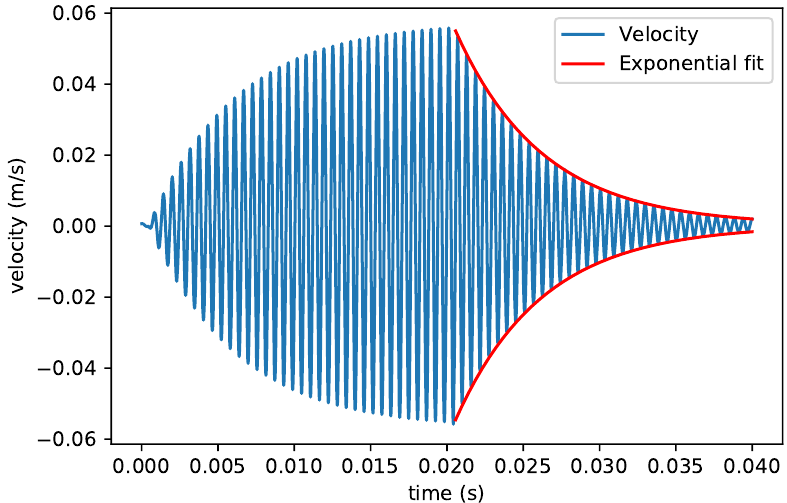
Figure 9. Measured velocity of the vibrating channel and exponential fit of the ring down process. This particular measurement was performed with the device from Figure 1d in the swing mode. The actuation voltage was applied at 0s and stopped after